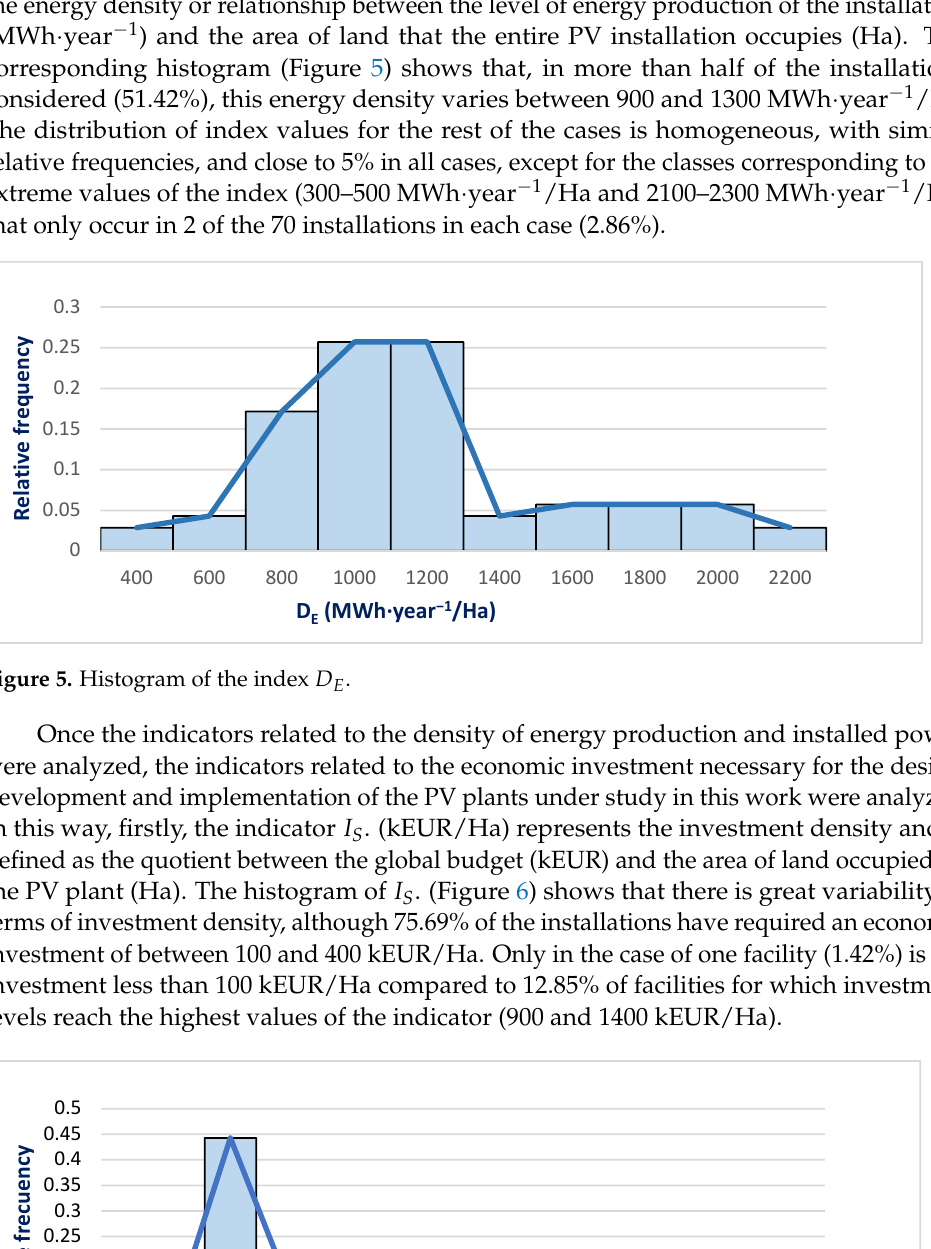
I (kEUR/Ha) s . Figure 6. Histogram of the index I S . Another parameter closely related to the return on investment will be the I PN (EUR/W) indicator since it represents the ratio between the global budget and the nominal installed power. Figure 7 shows that the most frequent values of this indicator vary between 0.50 and 0.70 EUR/W (54.28% of installations), followed by an investment between 0.40 and 0.50 EUR/W (12.85% of installations). The number of installations that require an investment greater than 0.70 EUR/W adds up to 25.71% of the cases; those greater than 1 EUR/W are 10.00% of the installations studied.